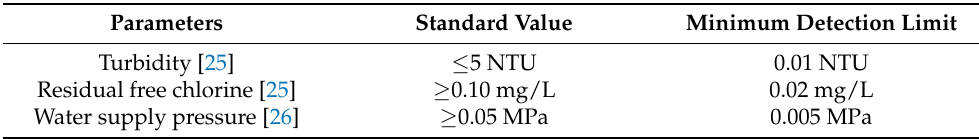
Table 3. National water quality standards for selected parameters in Cambodia, 2015